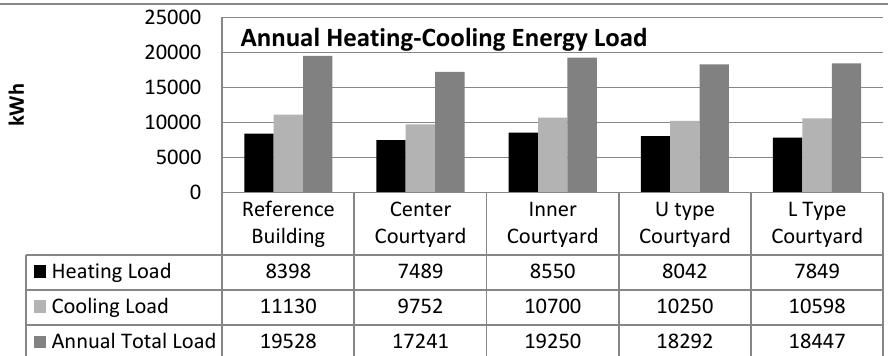
Figure 6. The effect of change of courtyard form on heating-cooling load values.